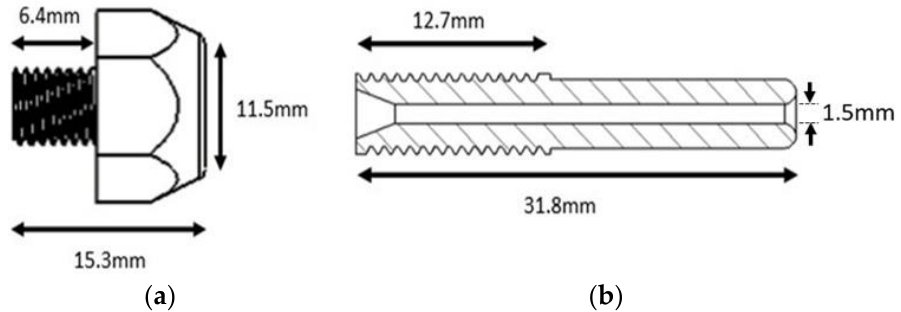
Figure 3. Dual gantry automation platform.